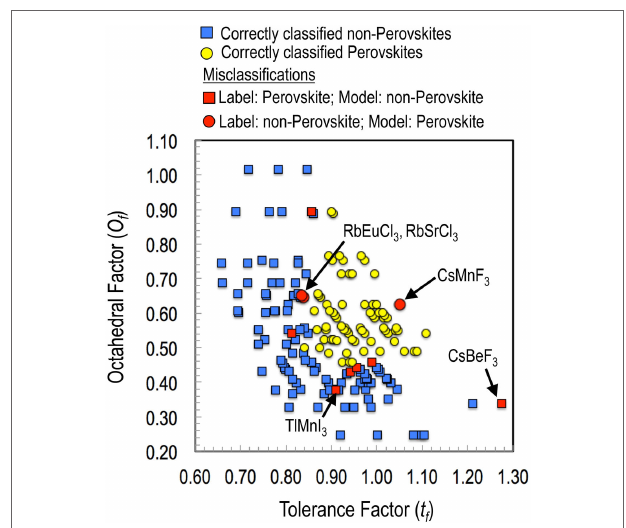
compounds in the target chemical space which have not yet been synthesized.